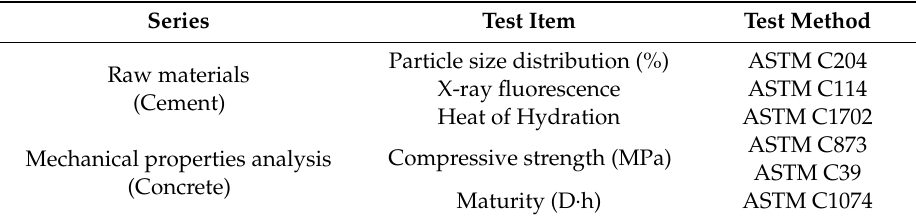
Table 4. Test methods for engineering properties of raw materials and concrete.